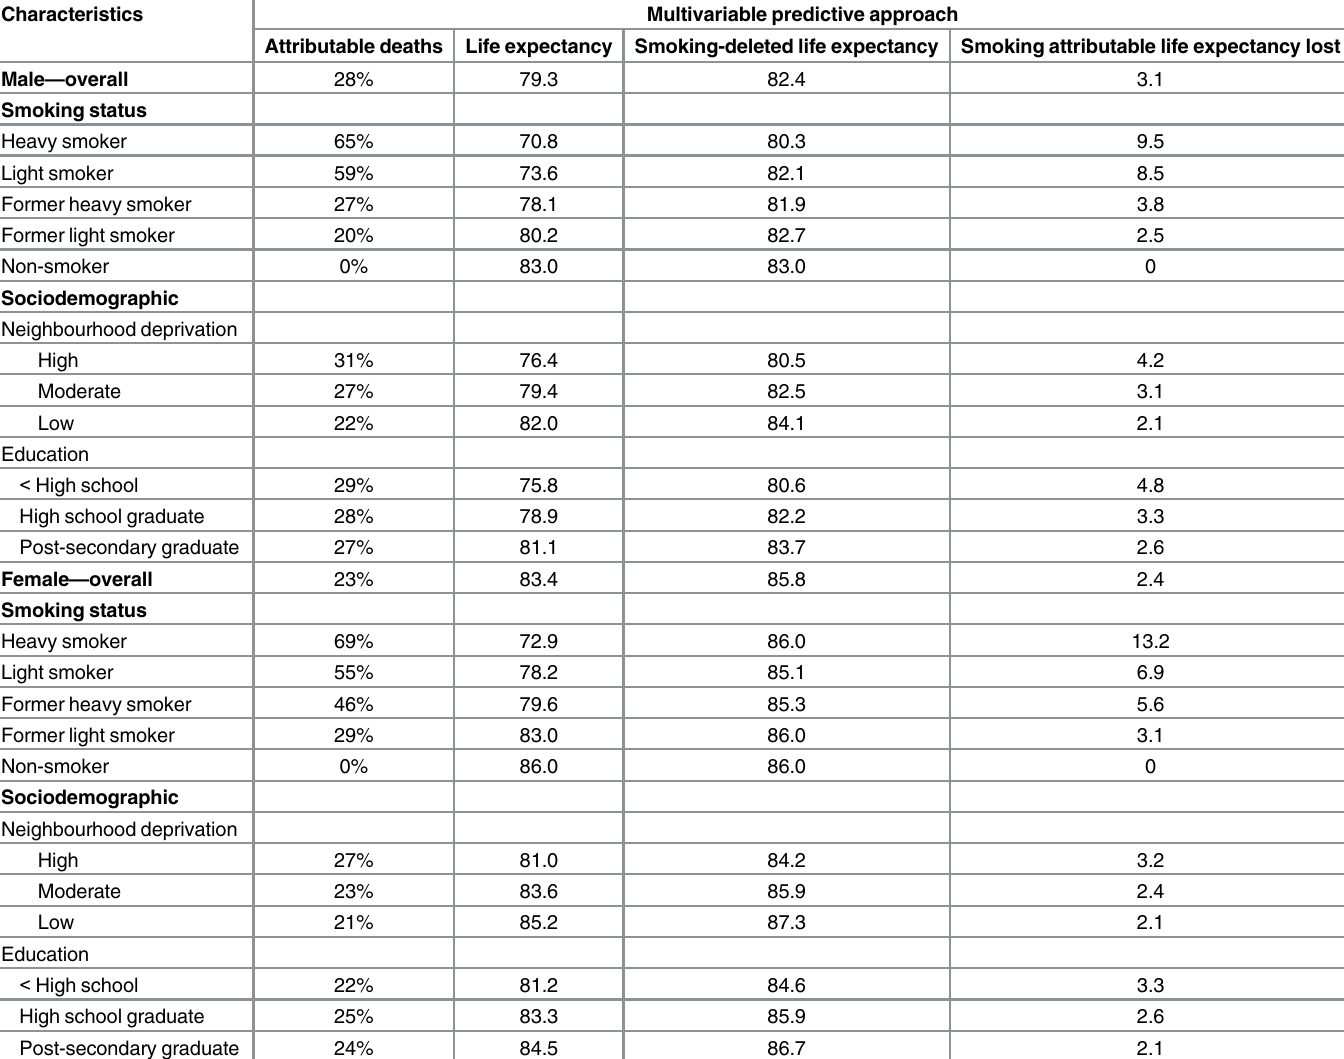
Table 5. Smoking-attributable mortality by smoking status and sociodemographic groups for males and females.